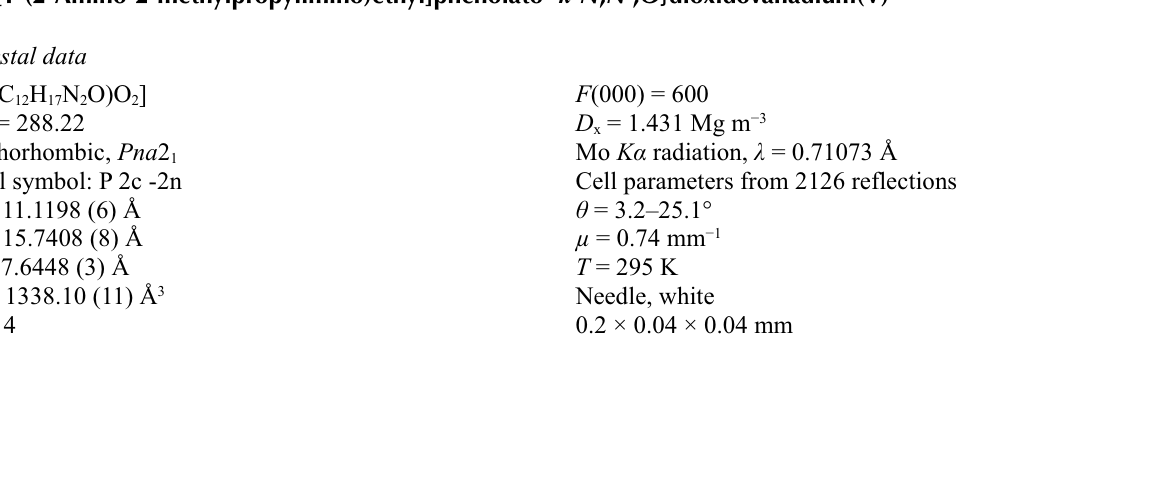
The arrangement of the molecules of (I) in the crystal structure viewed approximately along a axis. The C—H···O and N —H···O hydrogen bonds are represented by dashed lines and the C—H··· π interactions are represented by dotted lines. {2-[1-(2-Amino-2-methylpropylimino)ethyl]phenolato- κ 3 N , N ′ , O